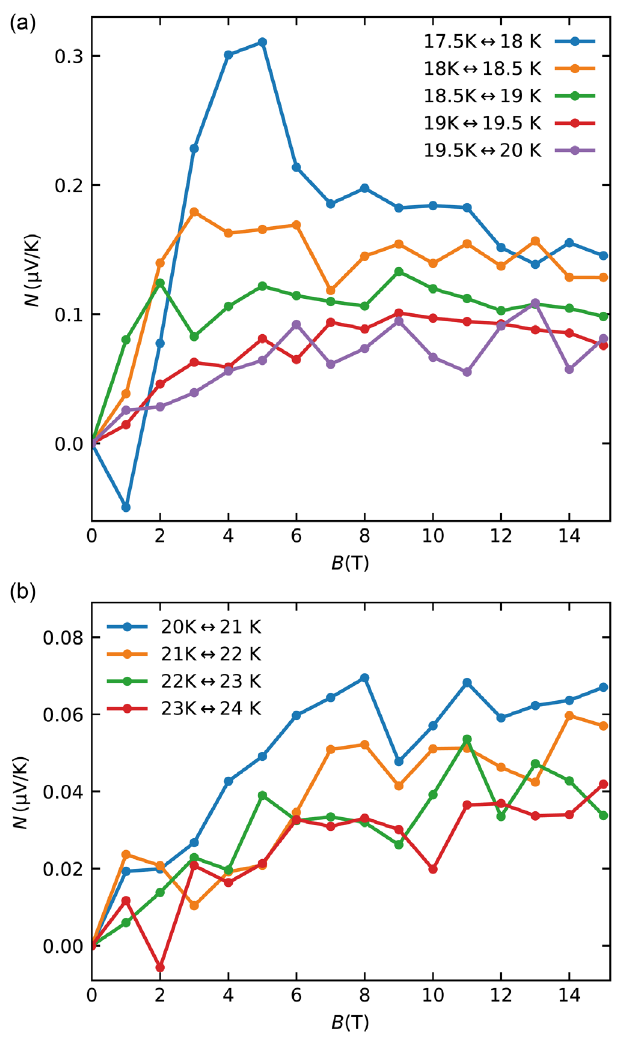
FIG. 8. Magnetic field dependence of the Nernst signal close to the critical temperature. (a) Quasiparticle-subtracted Nernst signal as a function of magnetic field for different temperatures just below T c and just above T c (b). Note the different vertical scales. A peak in N s above T c ð B Þ may indicate the presence of a ghost critical field (see